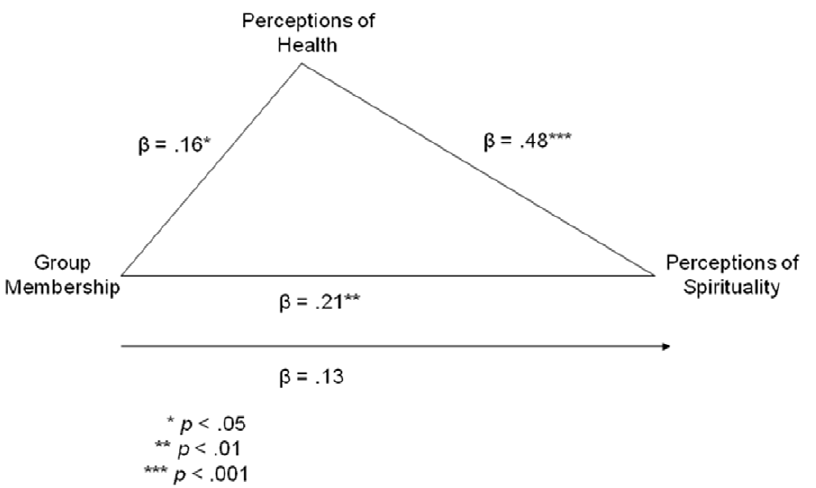
Figure 2. Statistical model illustrating the role of health in mediating the relationship between Mormon/non-Mormon group membership and perceptions of spirituality; standardized coefficients ( b ’s) are provided neighboring the model’s paths with indications of statistical significance.